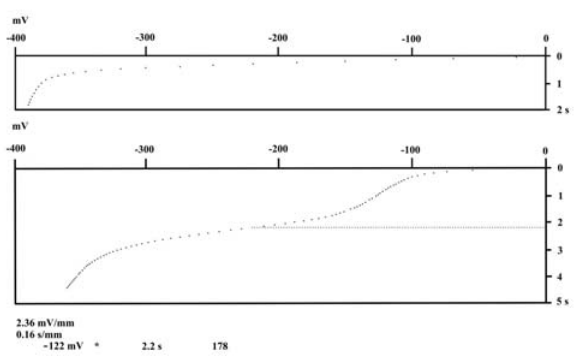
Figure 3. Chronopotentiogram at glassy carbon electrode in 0.025 mol/L HCl (a – upper) in the absence and (b – lower) in the presen- = 0.023 V, I = –1.3 μA. ce of 5 mg/L of riboflavin. E Initial